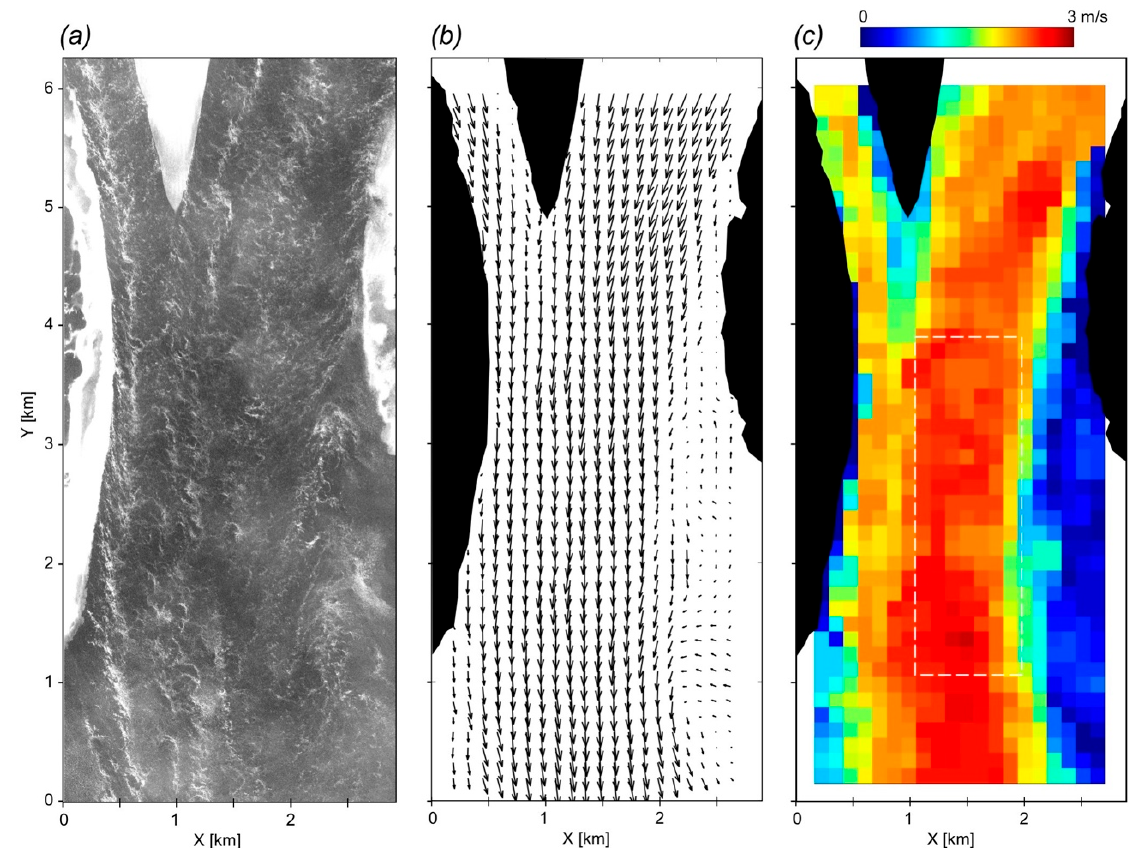
Figure 6. Velocity field at late-flood as derived from PIV analysis of an image pair (looks 5 and 6) having a time separation of Δ t = t 2 − t 1 = 12.6 s. ( a ) Red-edge imagery at time t 1 ; ( b ) velocity vectors; ( c ) velocity magnitude. Large, relatively bright and dark patches in the imagery are atmospheric artifacts. The longest vector in ( b ) has a length of 2.83 m/s. Note that the magnitude scaling differs from Fig. 5, as the upper limit here is only 3 m/s.